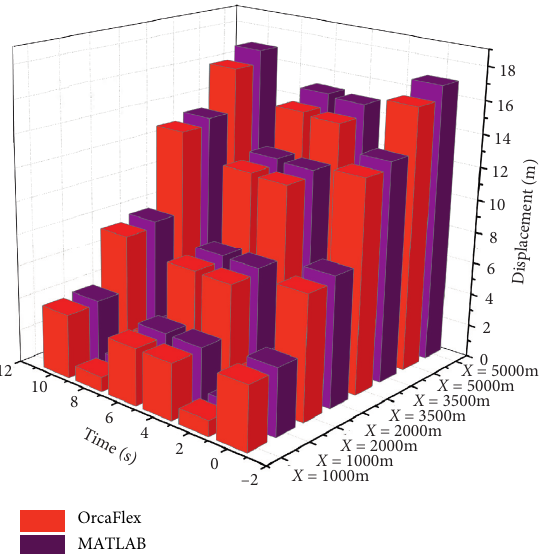
Figure 8: Comparison of longitudinal vibration simulation